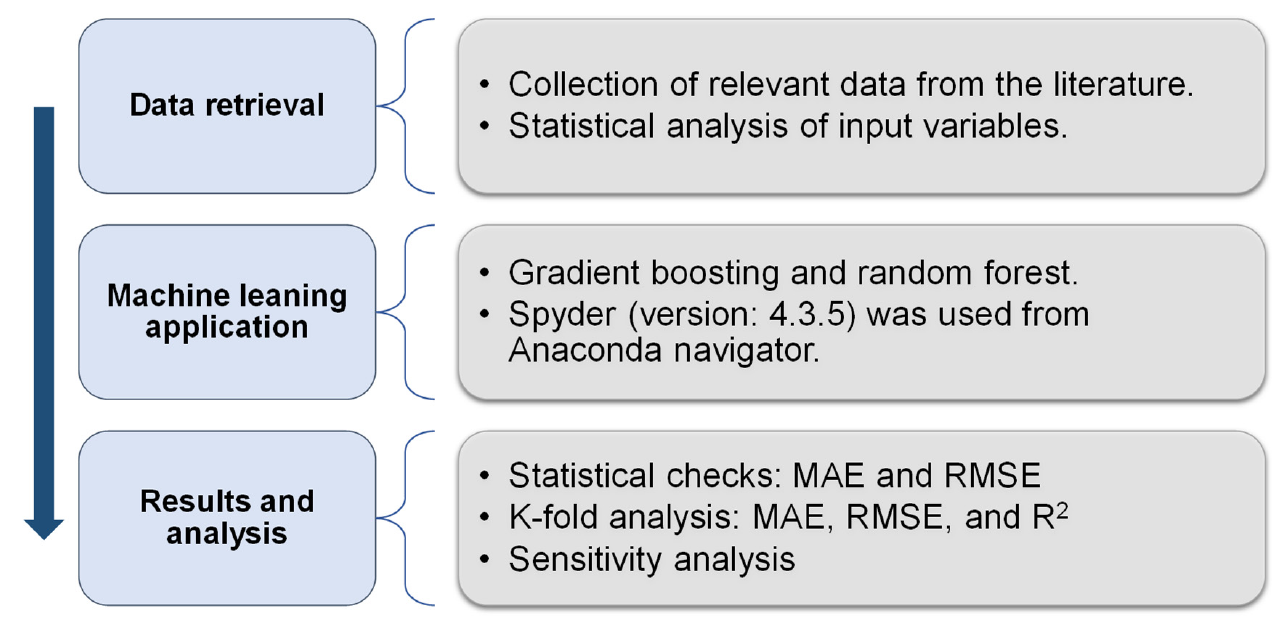
Figure 3. Flowchart of research methods.